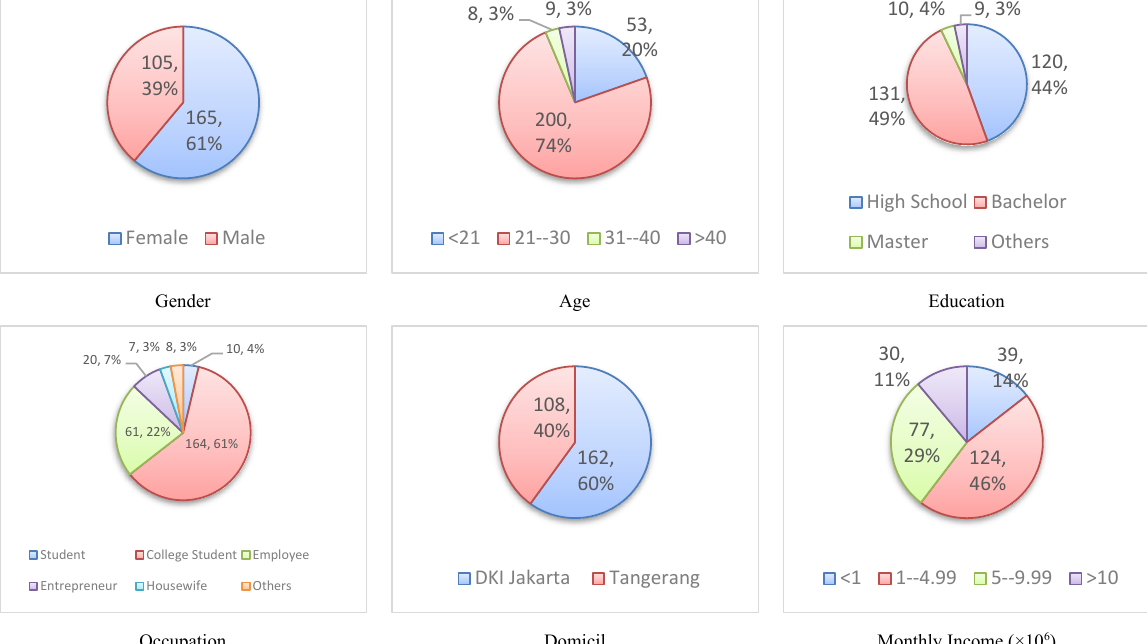
Fig. 2. Personal characteristics of the